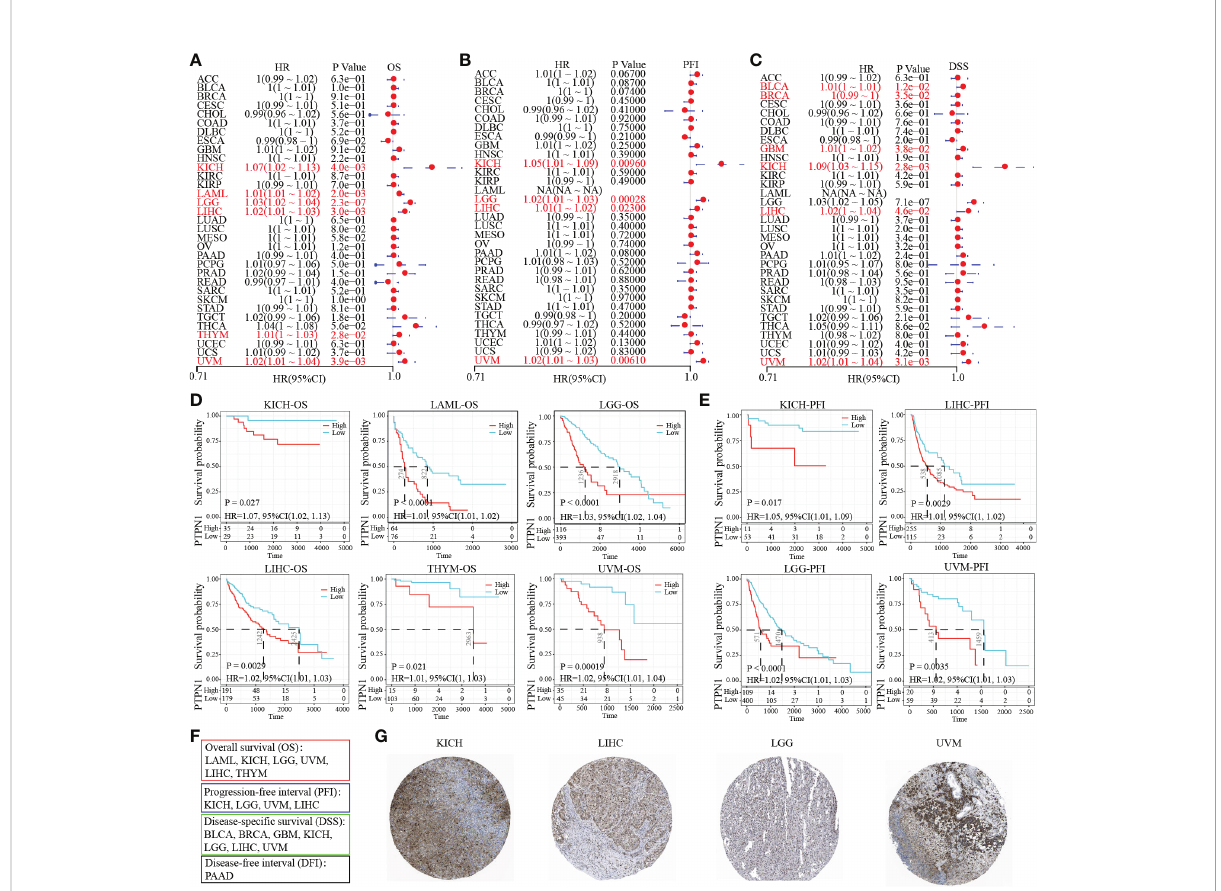
FIGURE 3 Prognostic value of PTP1B in different cancers. (A-C) The forest plot prognostic analysis of PTP1B on OS (A) , PFI (B) and DSS (C) in cancers. (D) Kaplan – Meier analysis of PTP1B on OS in KICH, LAML, LGG, LIHC, THYM and UVM. (E) Survival analysis of PTP1B on PFI in KICH, LGG, LIHC and UVM. P value and HR were showed in the bottom. (F) The summary of PTP1B survival related cancer types on OS, DFI, PFI and DSS. (G) Immunohistochemical expression of PTP1B in KICH, LGG, LIHC and